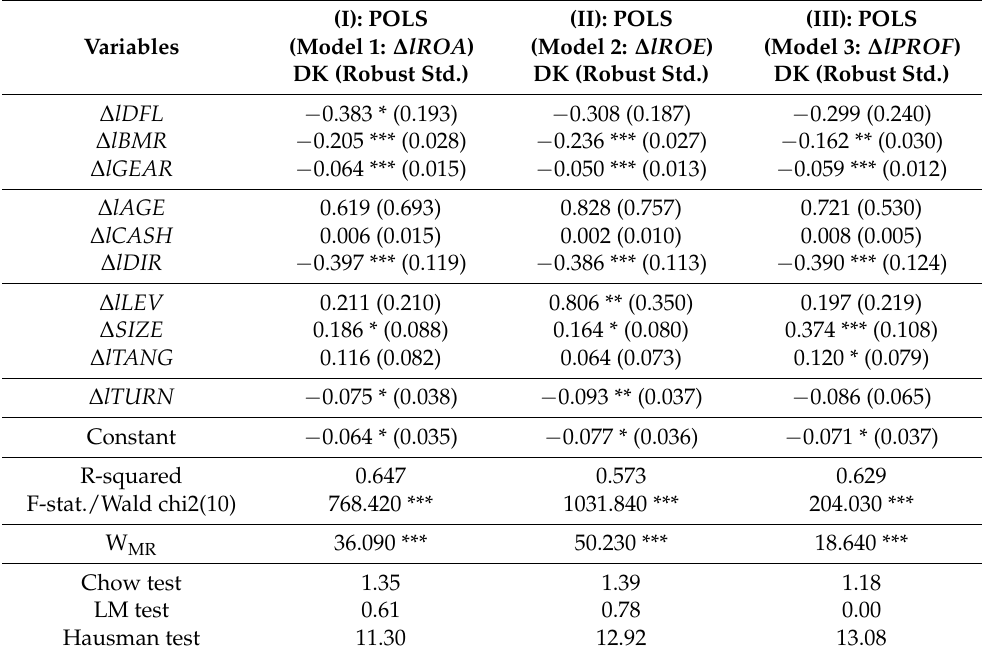
Table 6. Robustness using three measures of market risk with Driscoll and Kraay’s standard